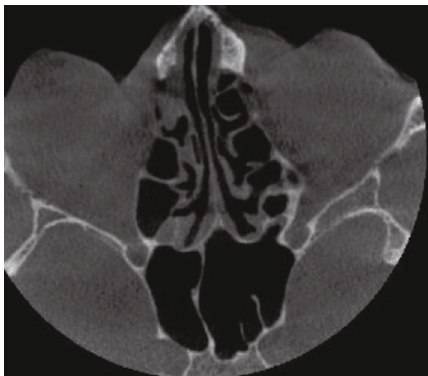
Figure 8: Axial view of CBCT scan revealing involvement of anterior and middle ethmoidal air sinus on the right